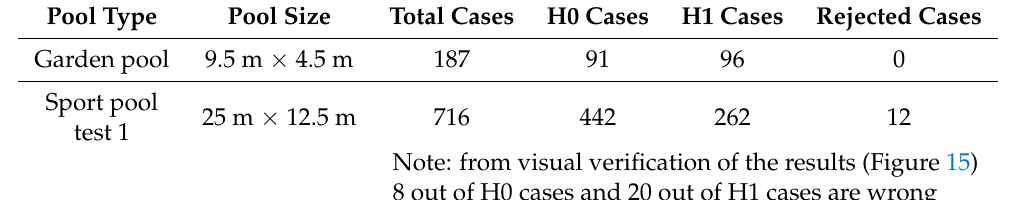
Table 2. Practical test results.